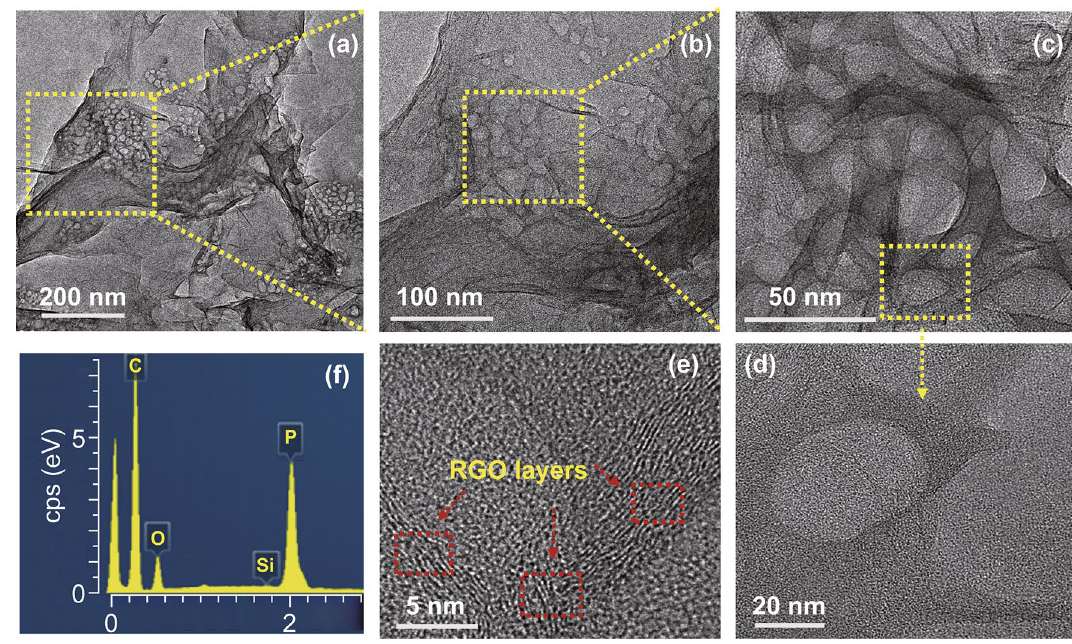
Fig. 3 a – e TEM and HRTEM images at different magnification. f Corresponding rP@rGO EDX graphs